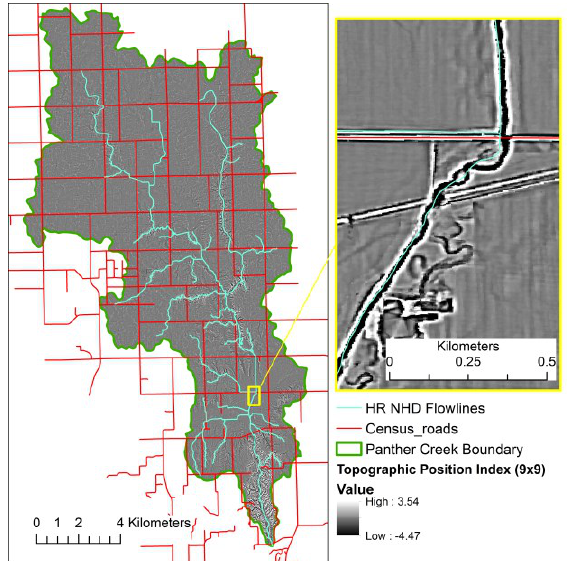
Figure 1. Topographic Position Index for the Panther Creek watershed in central Iowa. Census road lines and high- resolution National Hydrography Dataset flowlines are overlain in red and bright cyan, respectively. In the large-scale panel on the right, roads are manually breached to connect valleys in the